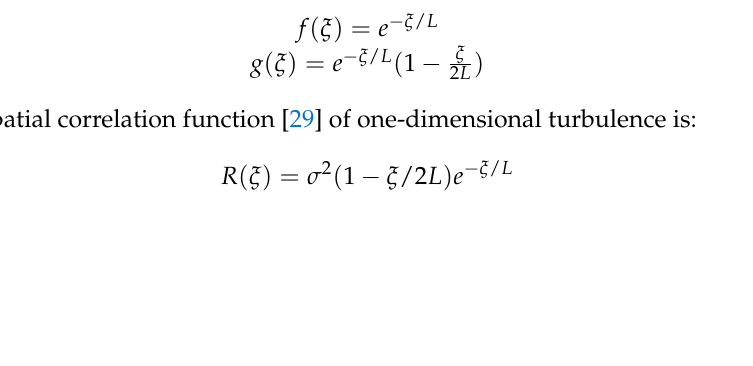
Figure 5. Comparisons between simulation results and measured data of low-level jet. ( a ) Wind profiles ( u ( x , H ) ) of low-level jet by simulation. ( b ) Wind profiles derived from the NCEP-NCAR reanalyzes and from the PACS-SONET upper-air observations [27] (© American Meteorological Society. Used with permission).